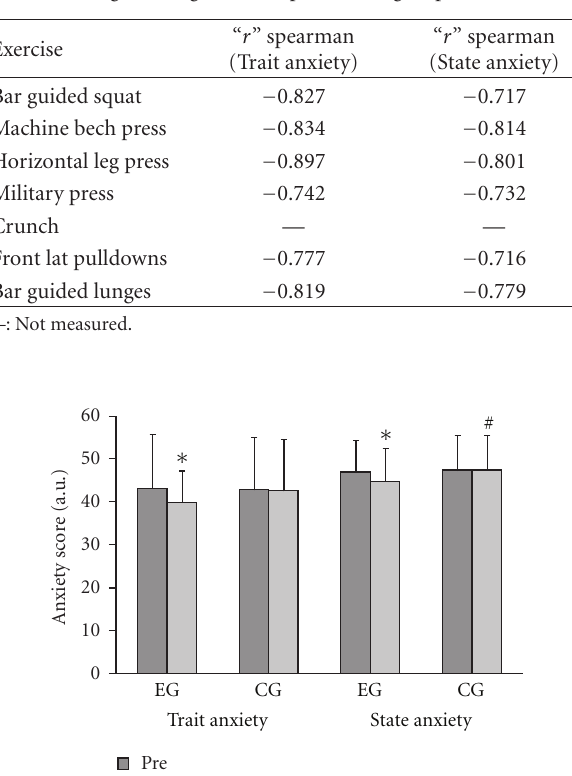
Table 2: Correlation between levels of anxiety and maximum load (1RM) in kilograms (kg) in the experimental group.